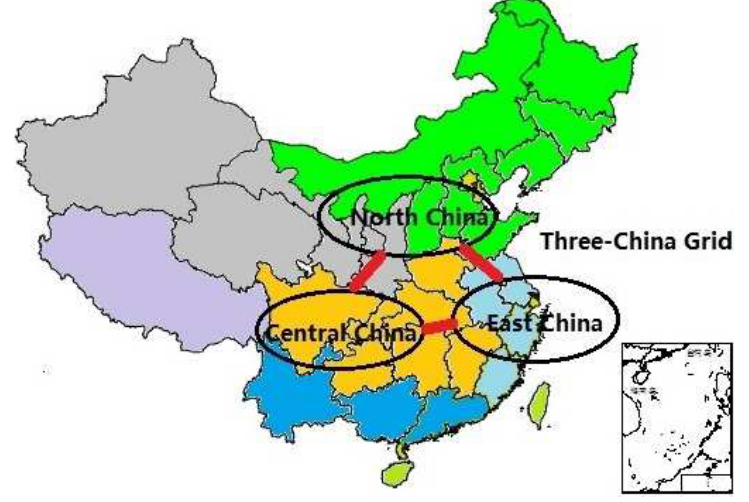
Figure 1. Diagram of the Three-China synchronous 1000 kV grid.